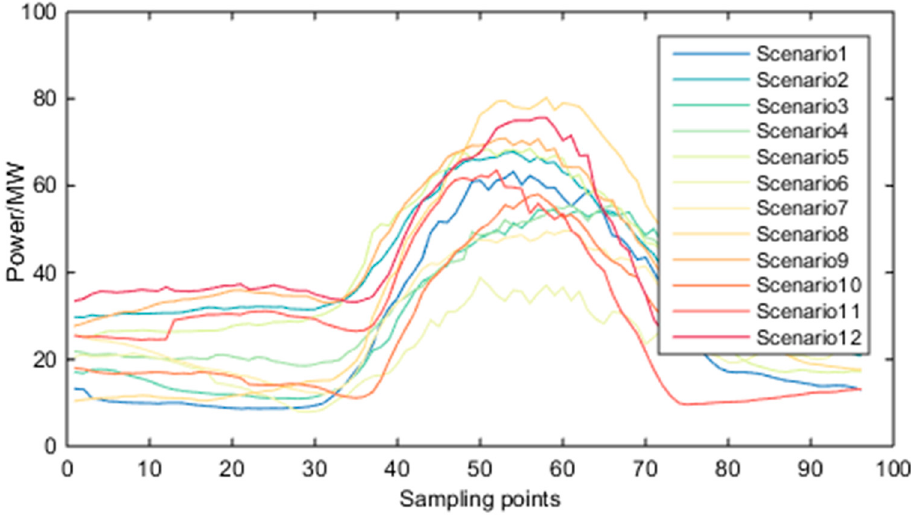
Figure 14. 12 Typical output scenario curves in the typical scenario model library. Table 9. Virtual power plant initial return and optimal return.